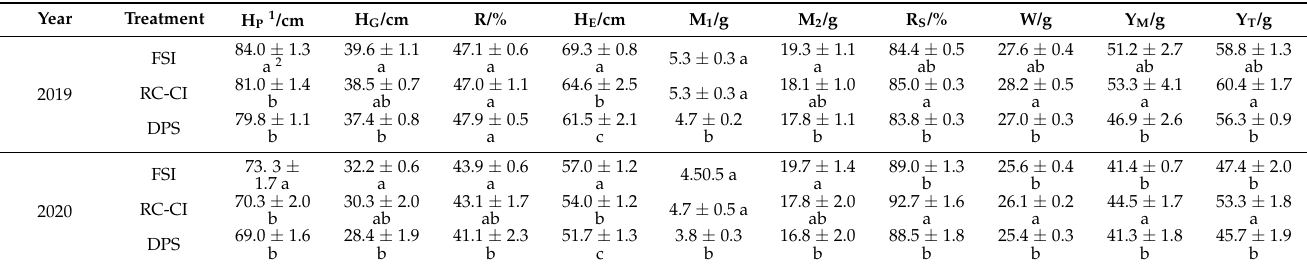
Table 4. Growth index of rice in different irrigation and drainage